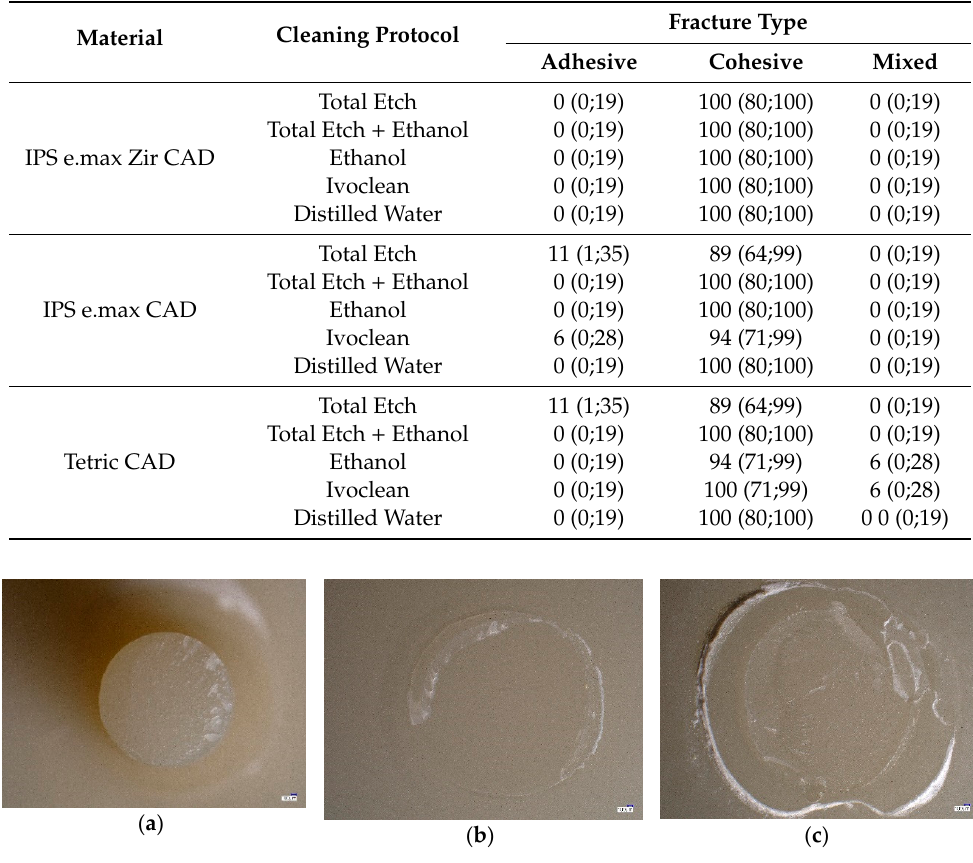
Table 4. Relative frequency of fracture types in % with 95% CI.